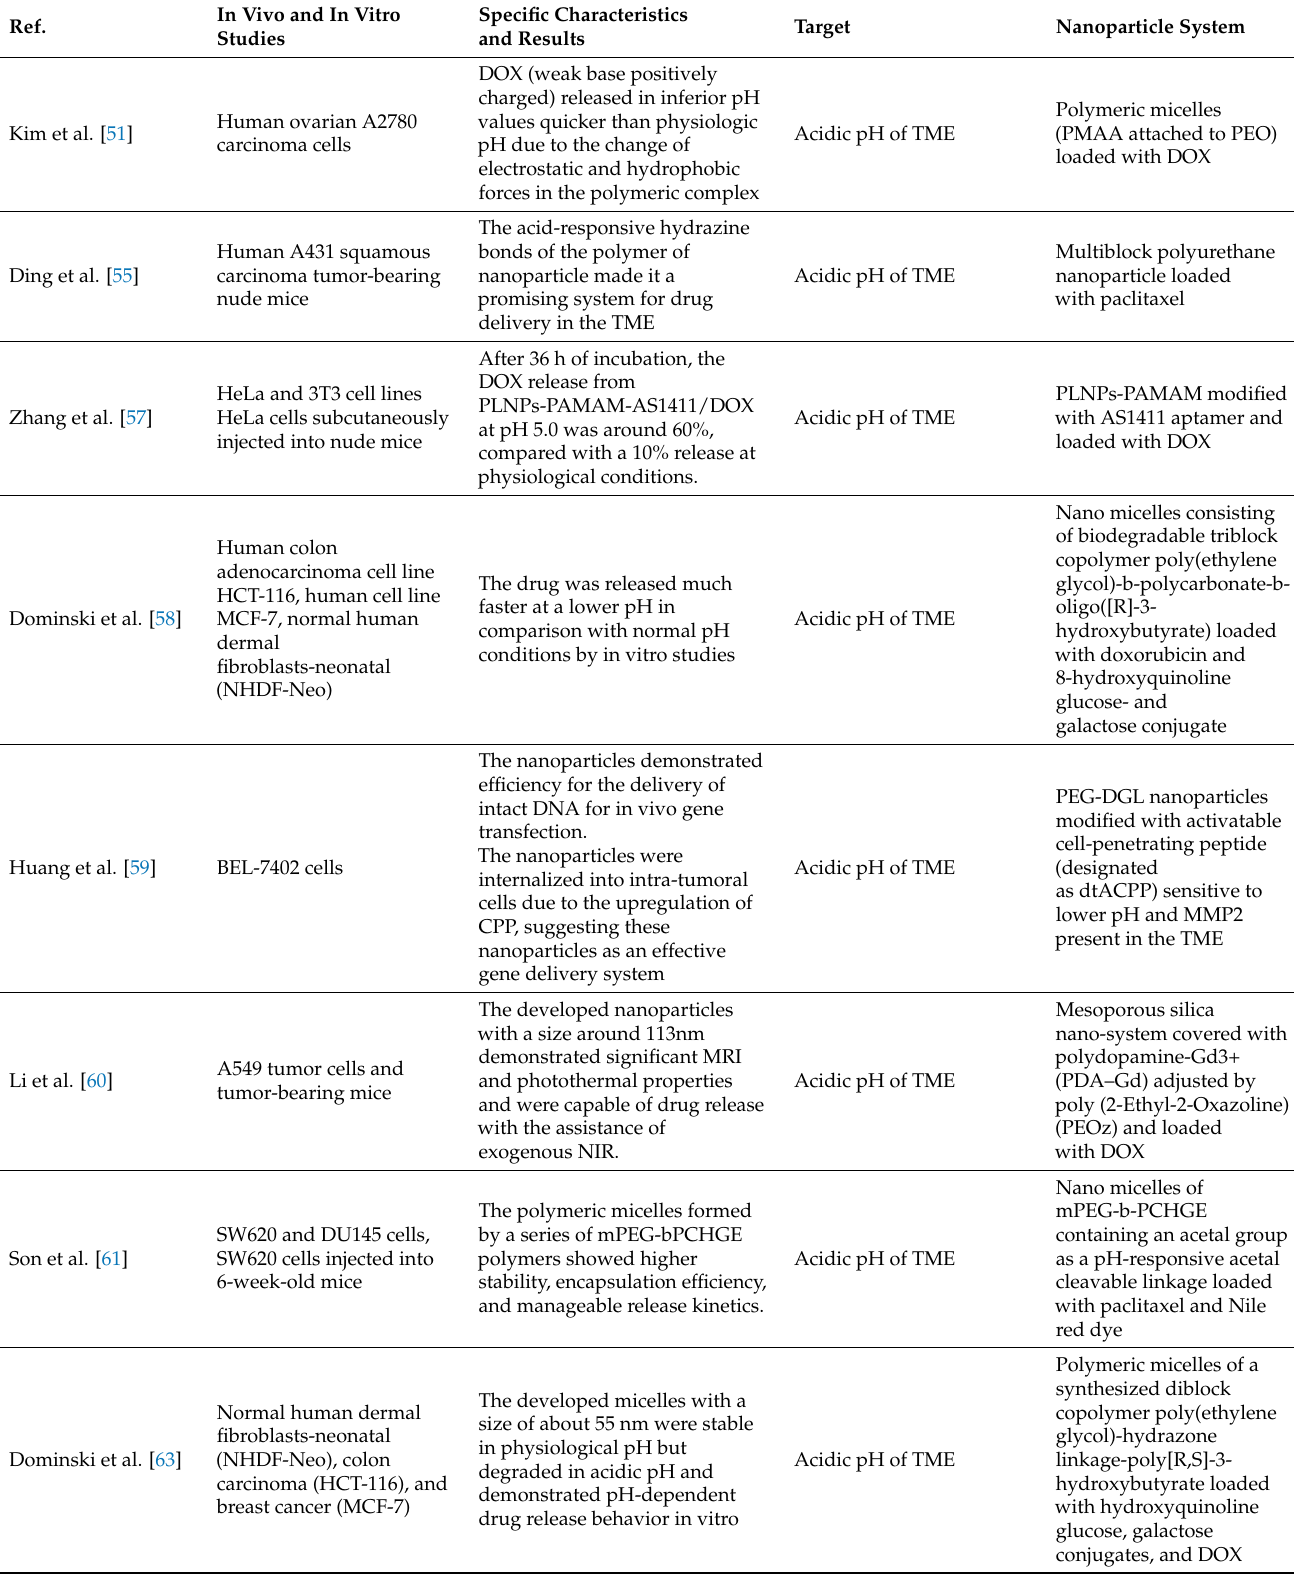
Table 1. Summary of targeted nanoparticles for cancer therapy discussed in this review.